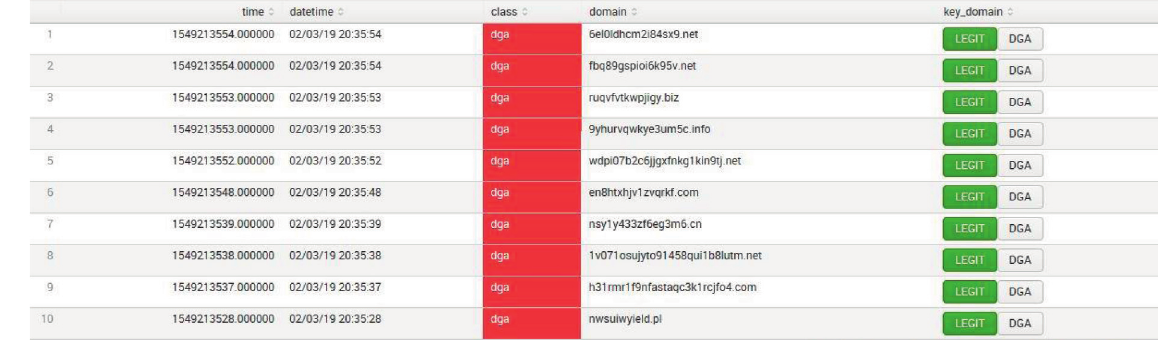
Figure 23: DGA detected domains and the editing prediction of domains detected